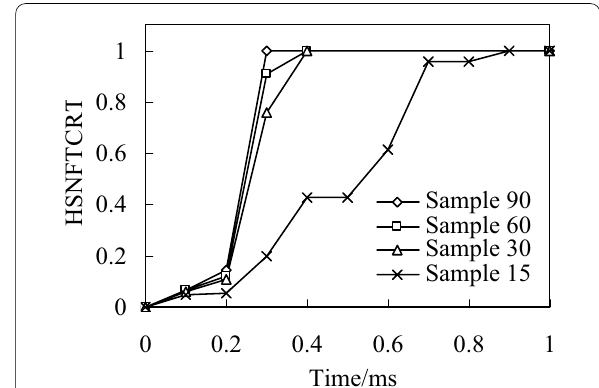
Fig. 6 Relationship of fiber tensile failure and impact time history